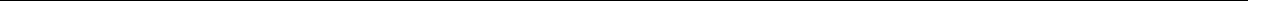
Fig. 3 Pro-in fl ammatory responses in the intestine of pik3c3 mutants. a Heatmap of in fl ammation-related genes shows the gradual stimulation of in fl ammatory response from 6 to 8 dpf in the mutants. b qRT-PCR analysis of the indicated in fl ammation-related genes. cxcl8a is the zebra fi sh homolog of IL8 . Experiments were performed and data analyzed as described in Fig. 2b. c mpx:GFP is a transgenic zebra fi sh line with neutrophils labeled by GFP. In 8 dpf mutants, neutrophils mainly accumulate in the digestive tract. Scale bar, 500 µ m. d High magni fi cation confocal imaging of ( c ). Scale bar, 50 µ m. e Cross sections of intestinal bulb in D8 embryos. Neutrophil in fi ltration of intestinal epithelium is clearly seen in the mutants. Scale bar, 50 µ m. f mpeg1: GFP-labeled macrophage lineage cells appear normal in the mutants. Scale bar, 500 µ m. g qRT-PCR analysis of the expression of IBD candidate genes in dissected intestine of pik3c3 mutants at 8 dpf. In fl ammatory response genes ( il1b , card9 , mmp9 ) and igfbp1a (one of the homologs of human IGFBP1 , a gene related to the prognosis of CD) are signi fi cantly up-regulated in the mutants. Bacteria sensing and autophagy-related genes ( nod2 , atg16l1, and irgm ) and tnfa are not stimulated. Barrier function-related genes hnf4a and ttc7a are severely down-regulated in the mutants while the hp gene, which functions to open up tight junctions, is up-regulated in the mutants. actb1 is used as internal control and data represent mean ± SD from three biological repeats. p -values are determined by unpaired two-tailed Student ’ s t -test (NS, non-signi fi cant; * p < 0.05; ** p < 0.01; *** p < 0.001; **** p <